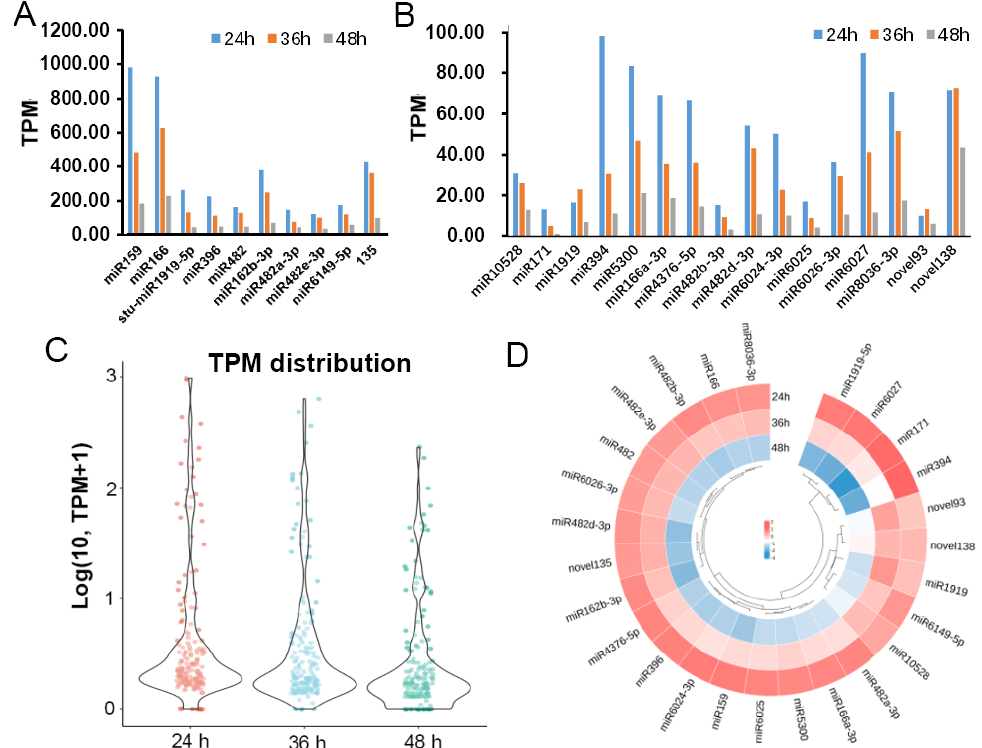
Figure 2. The expression profile of potato miRNAs in three time points after P. infestans inoculation. ( A ) The expression of 10 high-level-expressed miRNAs at 24 h/36 h/48 h. ( B ) The expression of 16 medium-level expressed miRNAs at 24 h/36 h/48 h. ( C ) Boxplot of the log transformed TPM (transcripts per million clean tags) expression values of 171 miRNAs. ( D ) Hierarchical clustering of the 26 differentially expressed miRNAs.